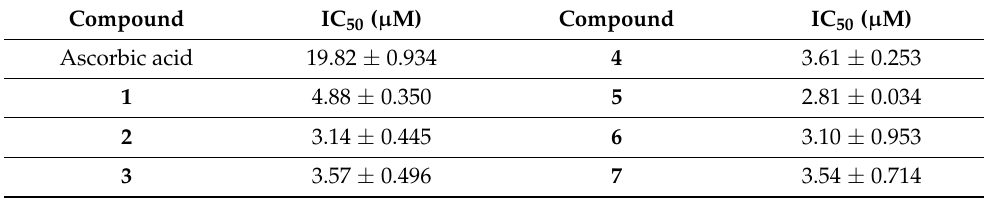
Table 1. In vitro ABTS radical scavenging activities of ascorbic acid, resveratrol 1 and analogues 2 – 7 .